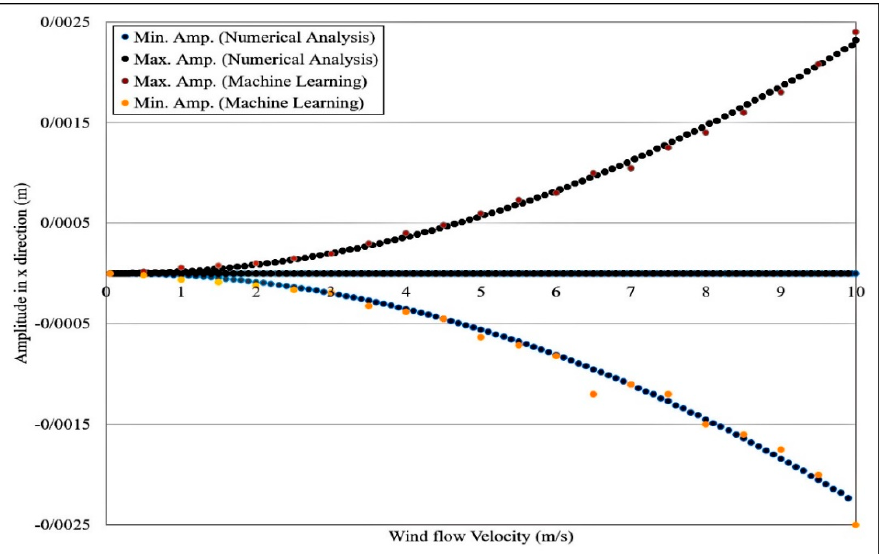
Figure 10. The effect of increasing the produced power on the amplitude of vibration.